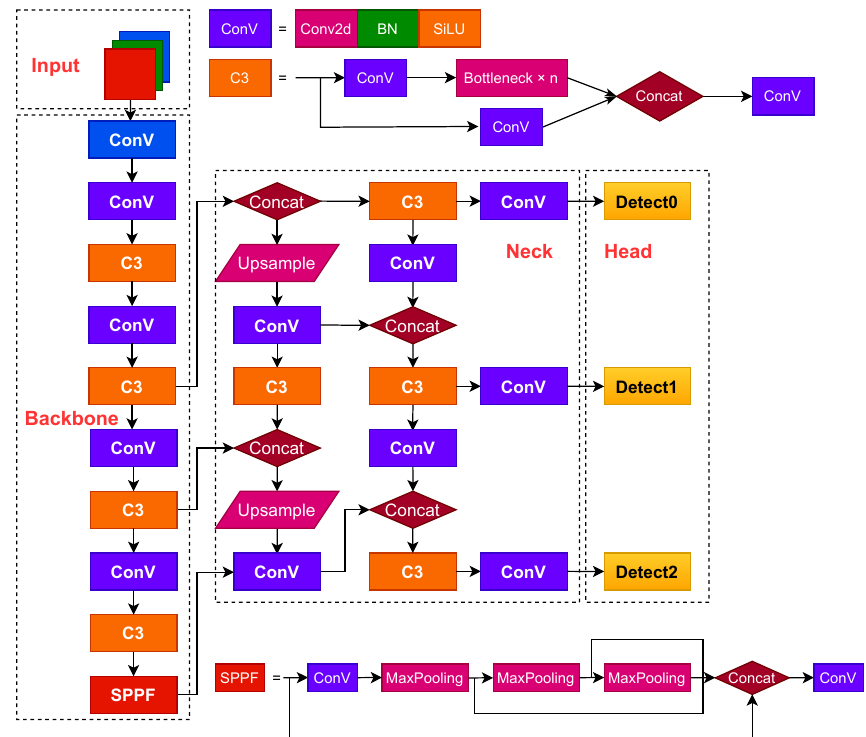
Figure 2. YOLOv5s network